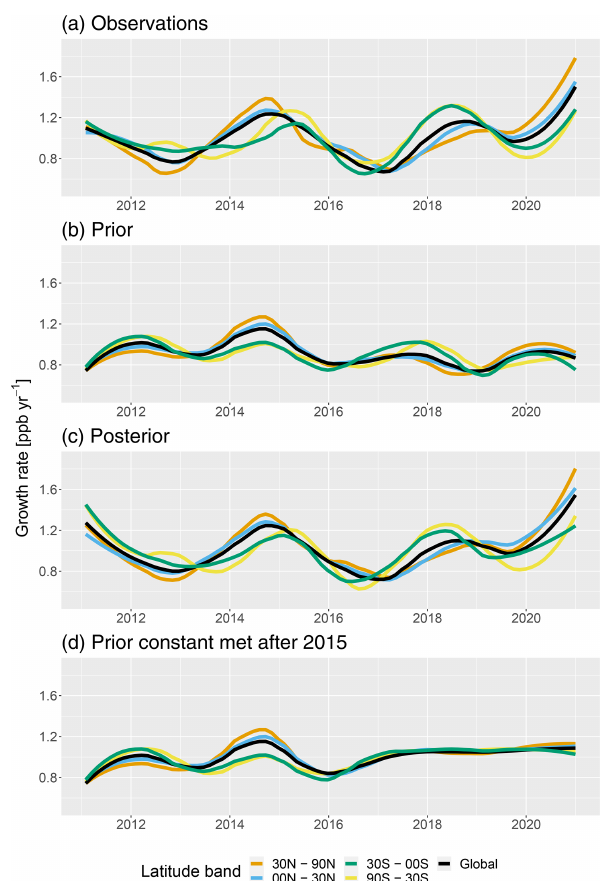
Figure 4. Atmospheric nitrous oxide surface growth rate for 2011– 2020 in four latitude bands and globally, for (a) the observations, (b) GEOS-Chem with the prior emissions, (c) GEOS-Chem with the posterior emissions, and (d) GEOS-Chem with repeating 2015 meteorology and prior emissions (which is the same as (b) except with constant meteorology after 2015). The growth rates have been smoothed using a LOESS (locally weighted smoothing) algorithm with a span of